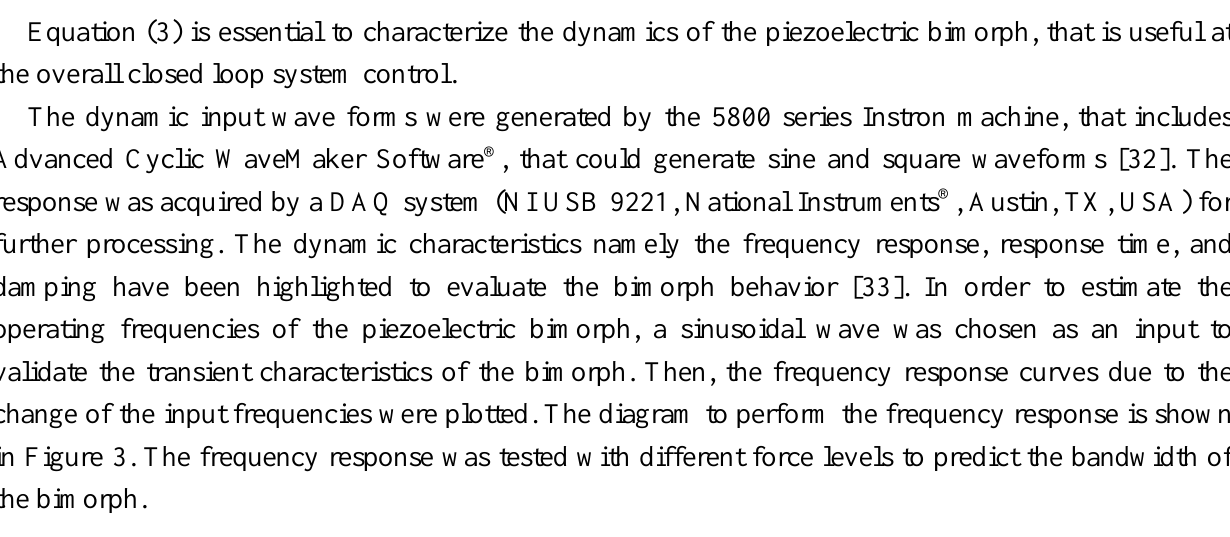
Figure 3. Block diagram shows the procedure of measuring the frequency response of the piezoelectric